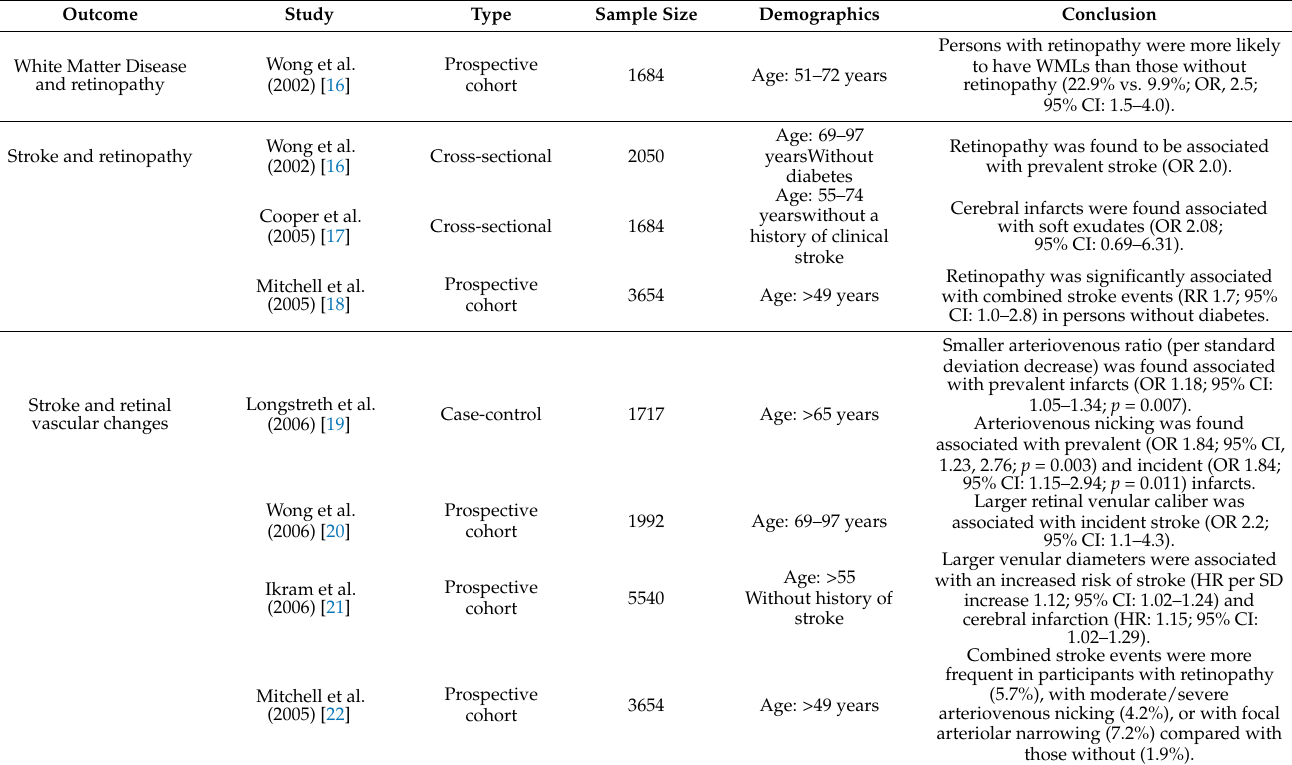
Table 2. Association of retinopathy and retinal vascular changes in cerebral vascular disease from population-based